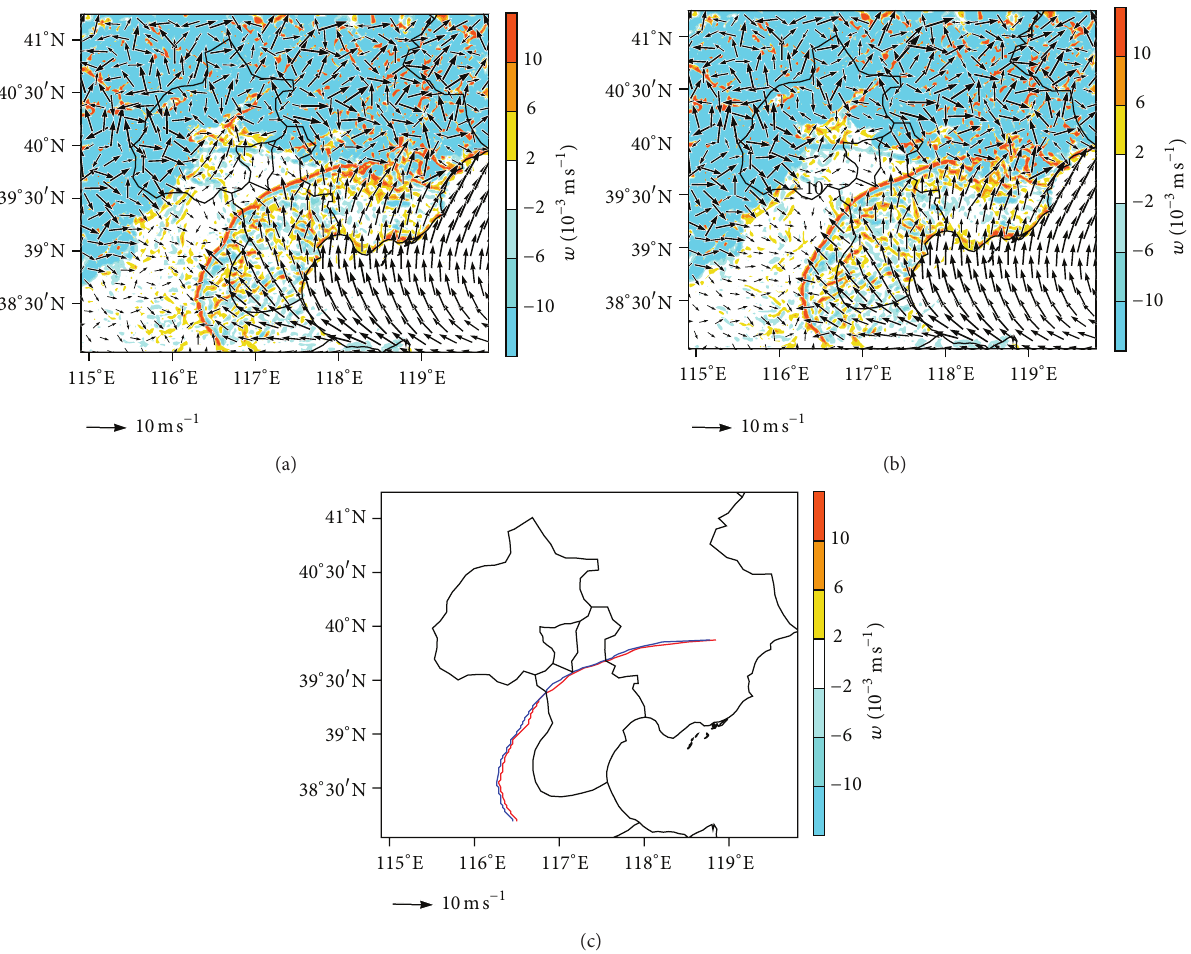
Figure 10: Simulated 10m wind field and the vertical wind component on the lowest vertical level at 2000 LST 24 August, 2013; (a) CNTL and (b) RURAL. The locations of sea breeze inland fronts of the CNTL (red) and RURAL (blue) experiments are indicated by the solid line in